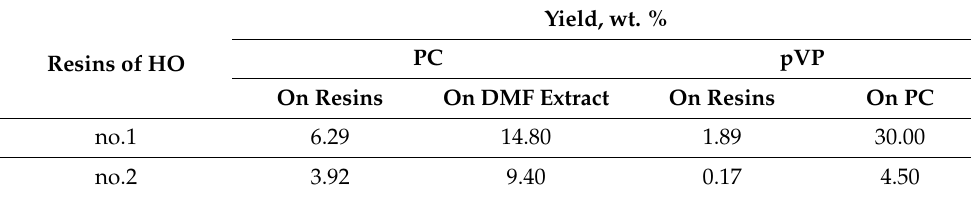
Table 5. Yield of PC and pVP from the resins of the oils.